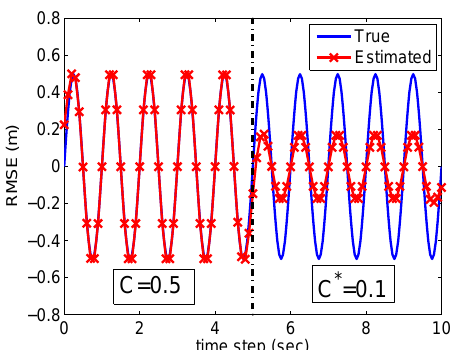
Figure 7. Sine function estimation using LapLS in Section 3.2 with different values of balancing parameters C and C ∗